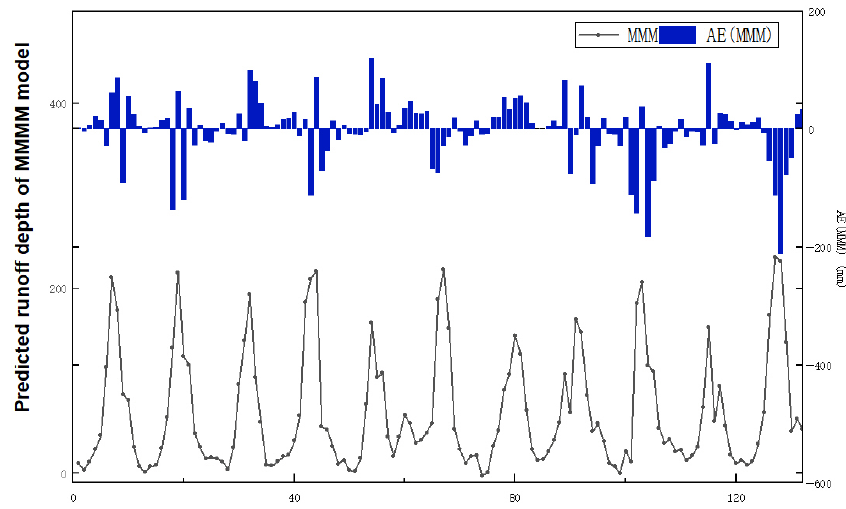
Figure 10. AE of MMM model.